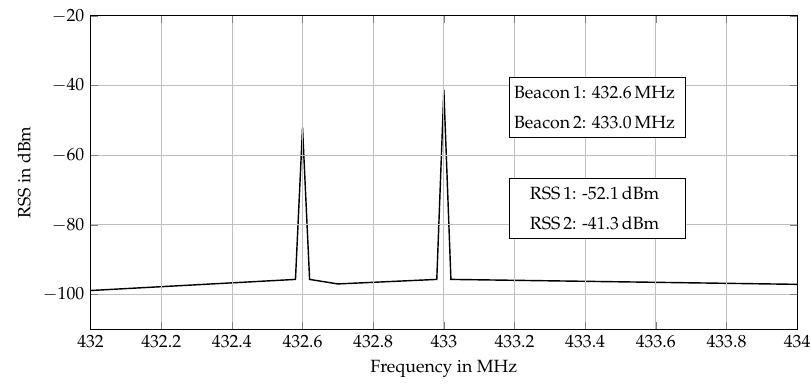
Figure 4. The underwater range sensor model (URSM) is applied to determine the range R i between receiver unit and the i th beacon. It maps the difference between received EM wave power S R, i and transmitted EM wave power S T, i to the range R i .